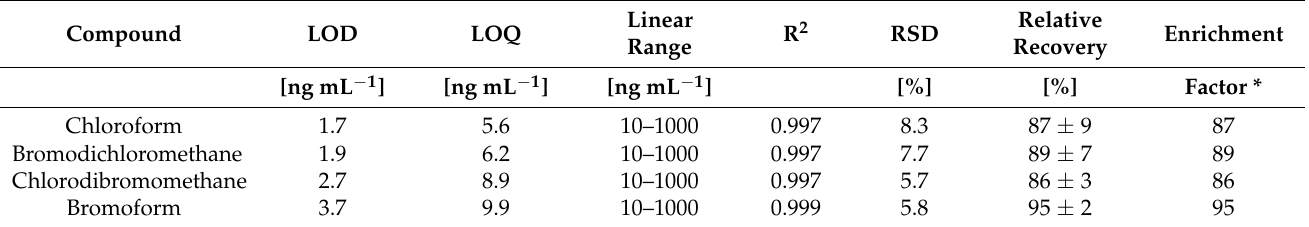
Table 4. Analytical characteristics of the developed HS-SPME-MMT-IL-AF system.